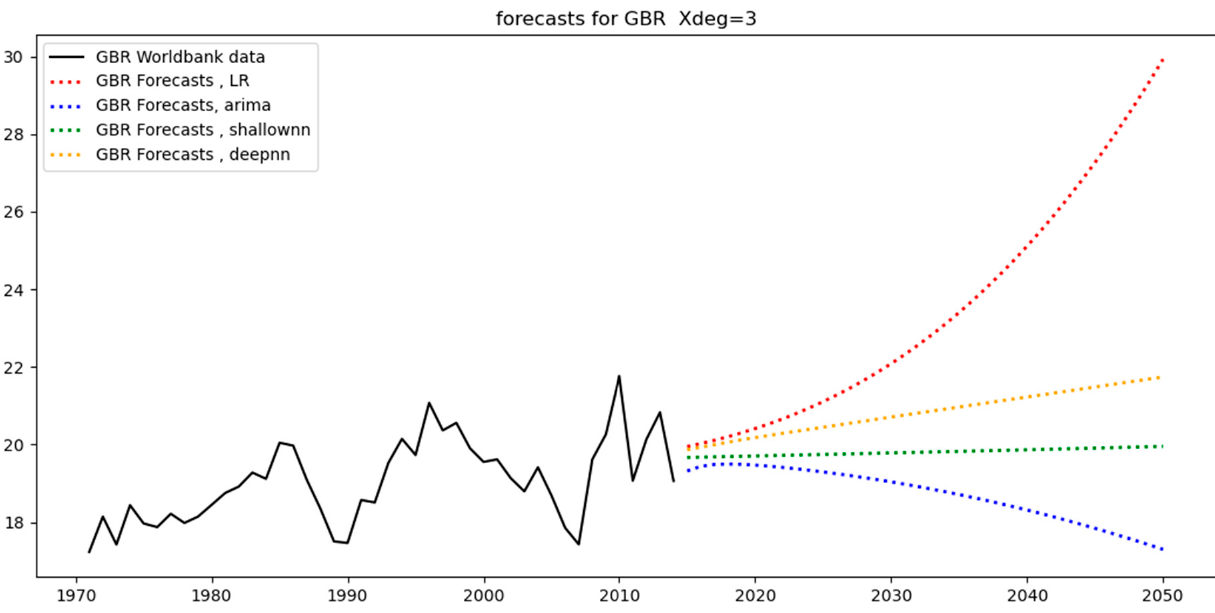
Figure 20. Forecasts for Great Britain (GBR), using linear regression (LR), ARIMA, shallow neural networks, and deep neural network models (third-degree polynomial for the features matrix).